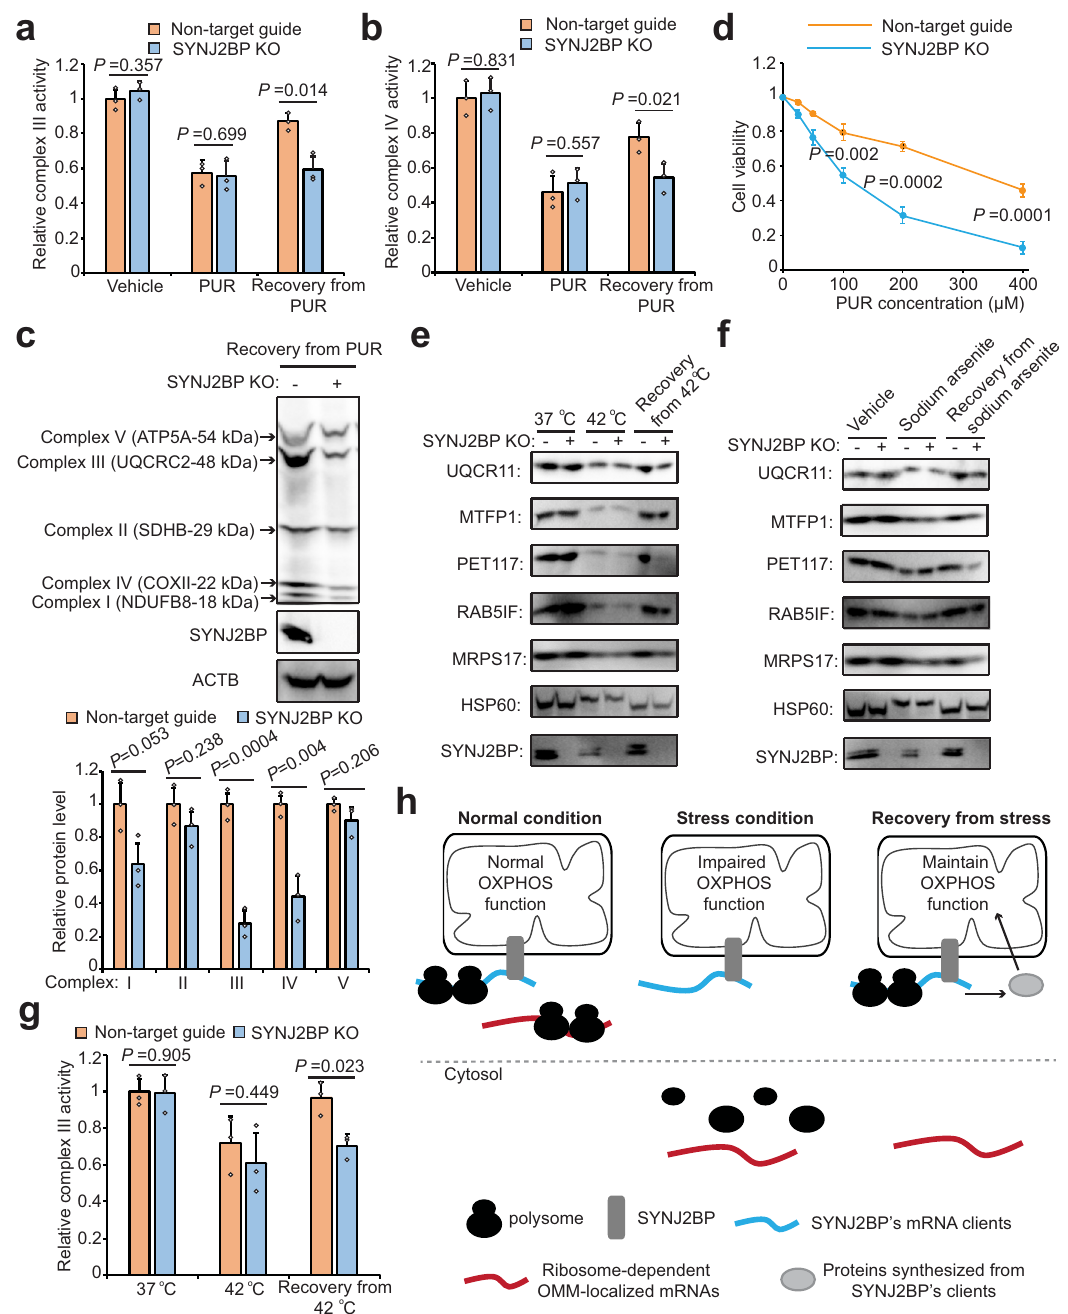
Fig. 7 SYNJ2BP improves mitochondrial OXPHOS recovery and cell viability following stress. a , b Evaluation of Complex III ( a ) and IV ( b ) activities in SYNJ2BP knockout cells. c Evaluation of complex I – V assembly 12 h following treatment of HEK cells with protein translation inhibitor PUR. The quanti fi cation of each OXPHOS complex is shown below; data from three independent biological replicates. d Evaluation of cell viability 12 h following treatment of HEK cells with PUR. e , f Evaluation of protein synthesis for SYNJ2BP clients in SYNJ2BP knockout cells following heat ( e ) and sodium arsenite ( f ) stresses. The quanti fi cation of western blot data from three biological replicates is shown in Supplementary Fig. 12b-c. g Evaluation of Complex III activity in SYNJ2BP knockout cells following heat stress. h Working model of SYNJ2BP ’ s role in retaining important (blue) mRNAs at the OMM during stress, to facilitate their rapid local translation for restoration of mitochondrial function during stress recovery (right). Two-sided Student ’ s t -test was performed and values represent means ± SD from three biological